Question: Provide a one-line summary of what is displayed.
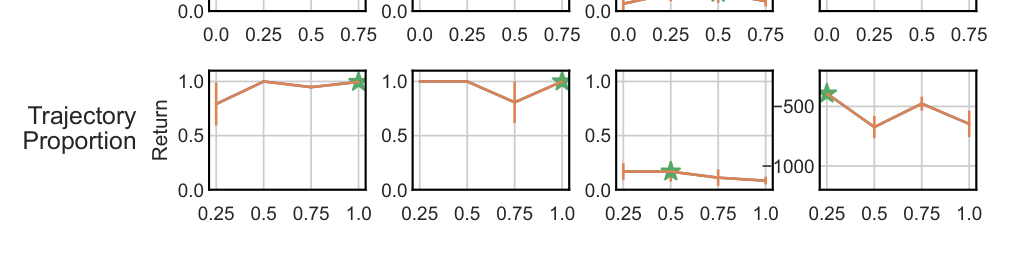
Answer: Hyperparameter sensitivity analysis. We vary the selected configuration one hyperparame- ter at a time, and present the mean and standard deviation for each configuration. The configurations used in the experiments are marked with a green star.